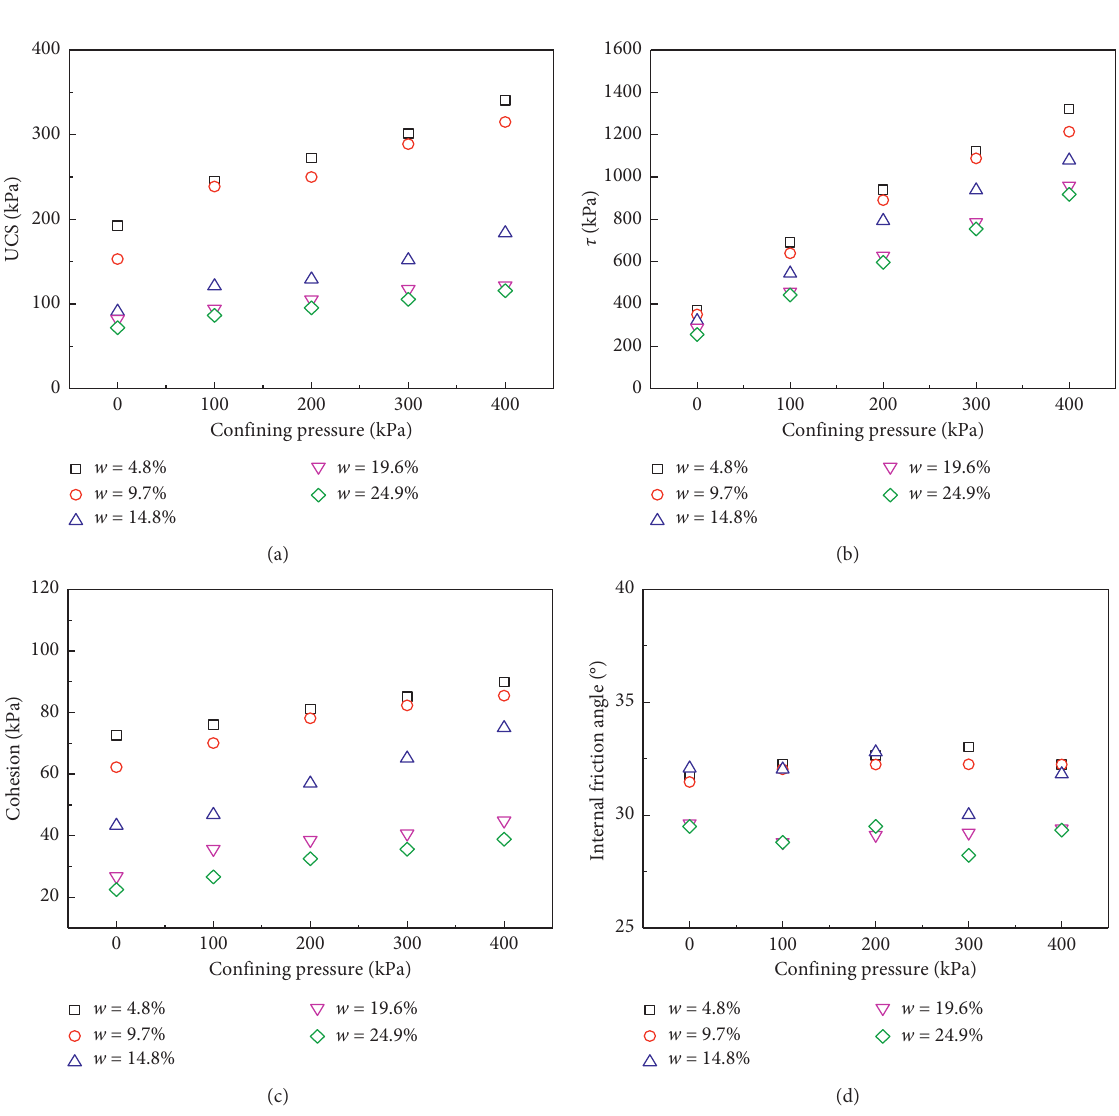
Figure 7: Patterns in changes of mechanical parameters under the influence of water content and confining pressure: (a) unconfined compressive strength (UCS), (b) shear strength, (c) cohesion, and (d) internal friction